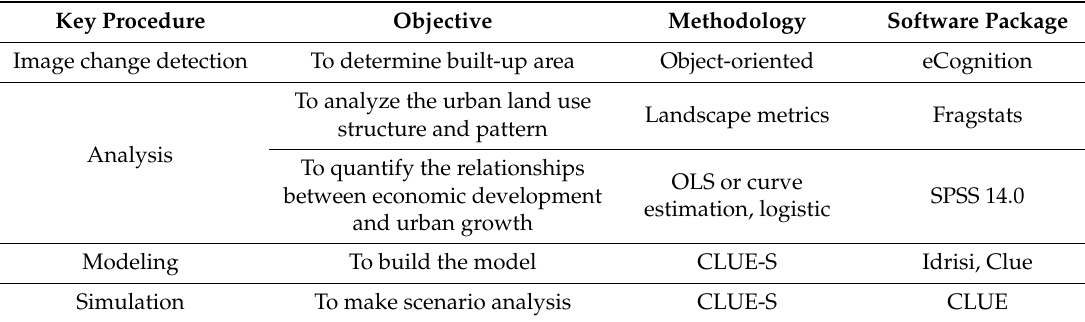
Table 2. Main research procedures and objectives, methodology, and software